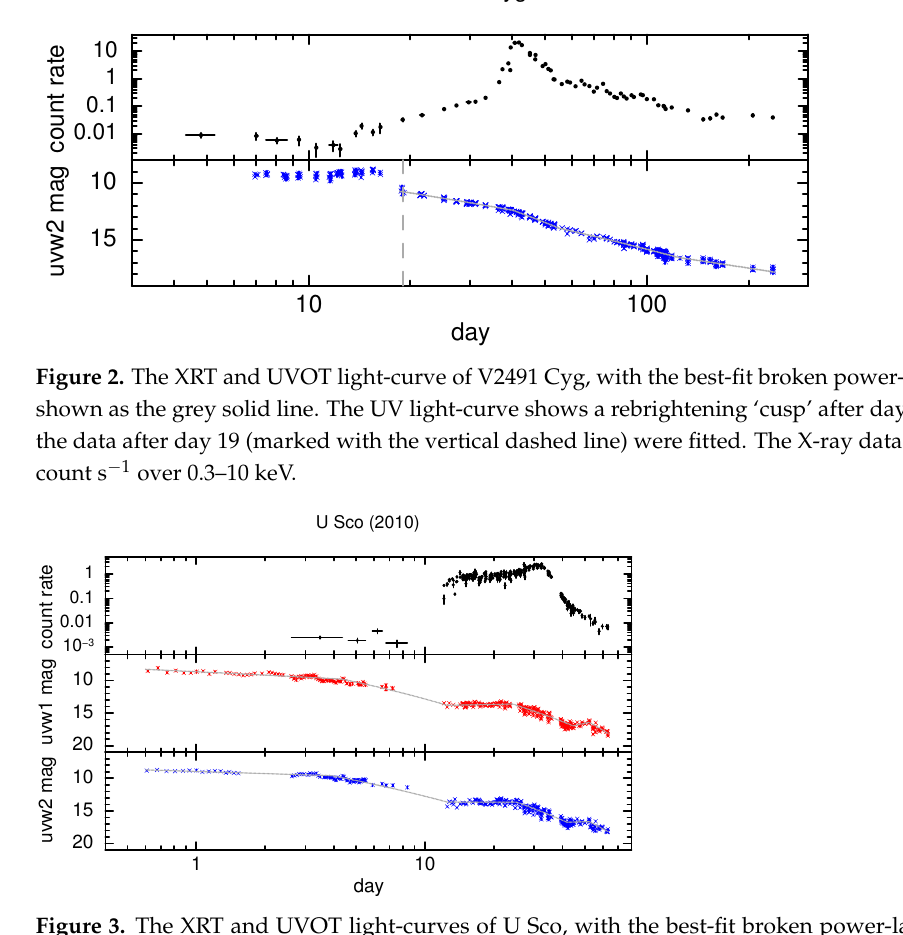
Figure 3. The XRT and UVOT light-curves of U Sco, with the best-fit broken power-law declines shown as the grey solid lines. The X-ray data (top) are in count s − 1 over 0.3–10